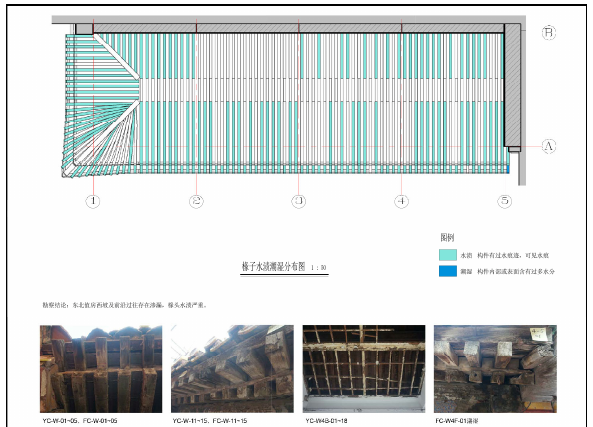
Figure 10 Example of thematic drawings; theme: traces of leakage